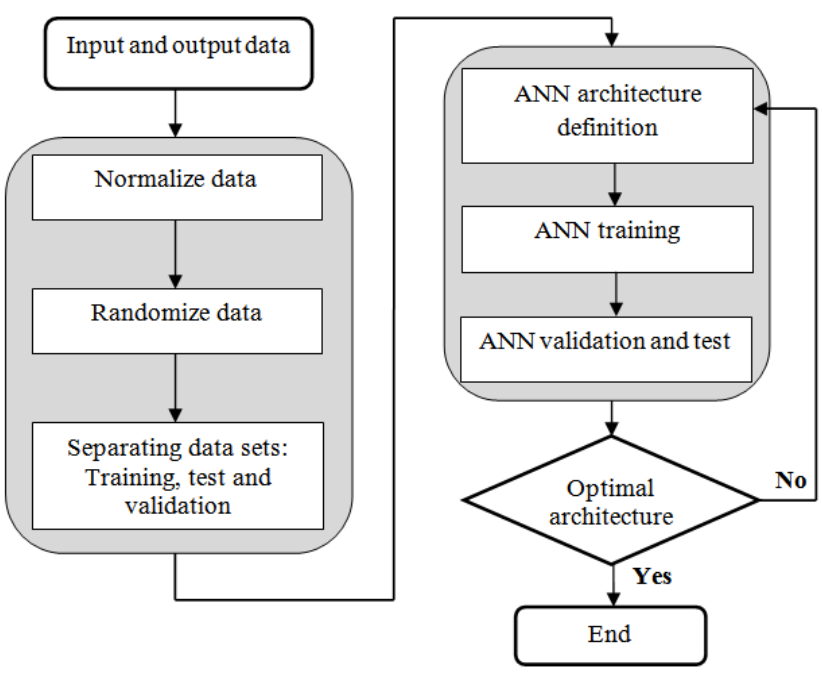
Figure 7. Flowchart with data pre-processing and artificial neural network training.